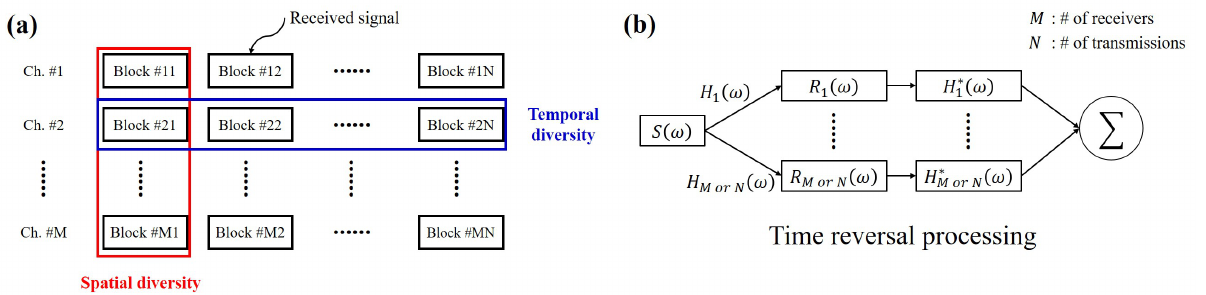
Figure 1. ( a ) Schematic of the methods used to select the received signals. The spatial and temporal diversity methods utilize the received signals in the red and blue boxes, respectively. ( b ) Block diagram for passive time reversal processing (TRP) using the spatial or temporal diversity